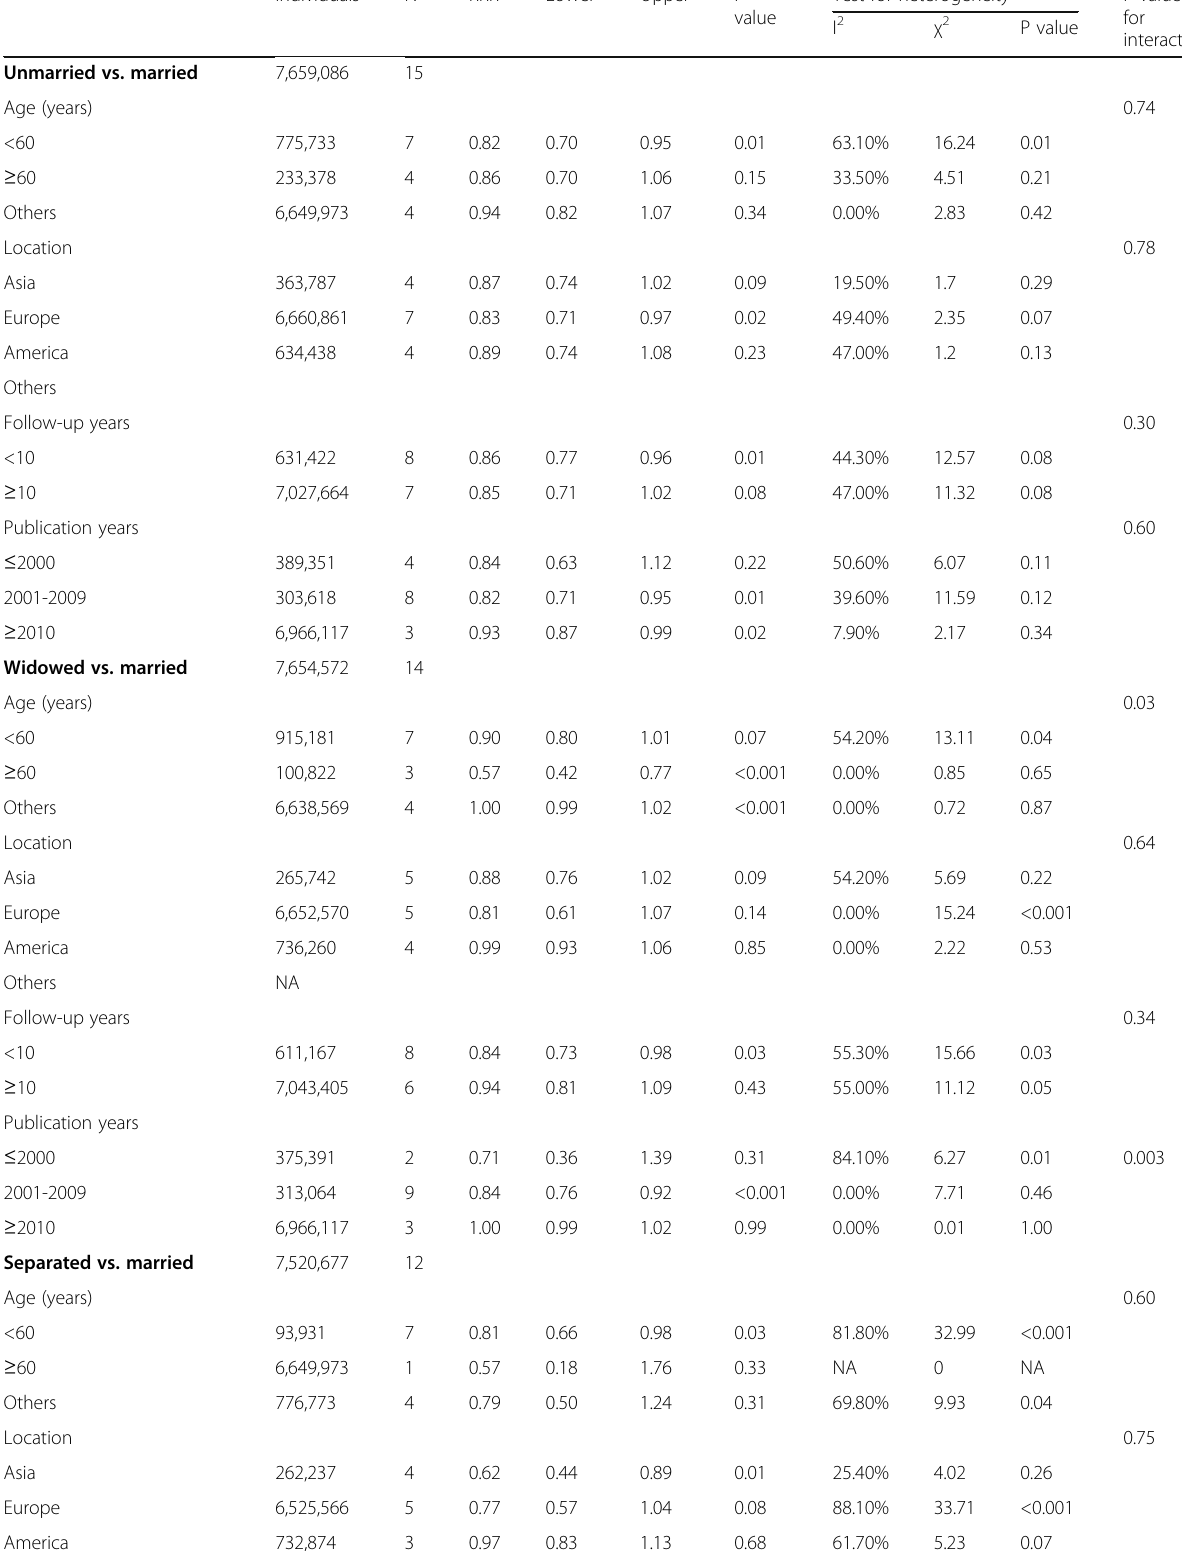
Table 2 Sensitivity analyses of women-to-men ratio of relative risks for all-cause mortality associated with marital